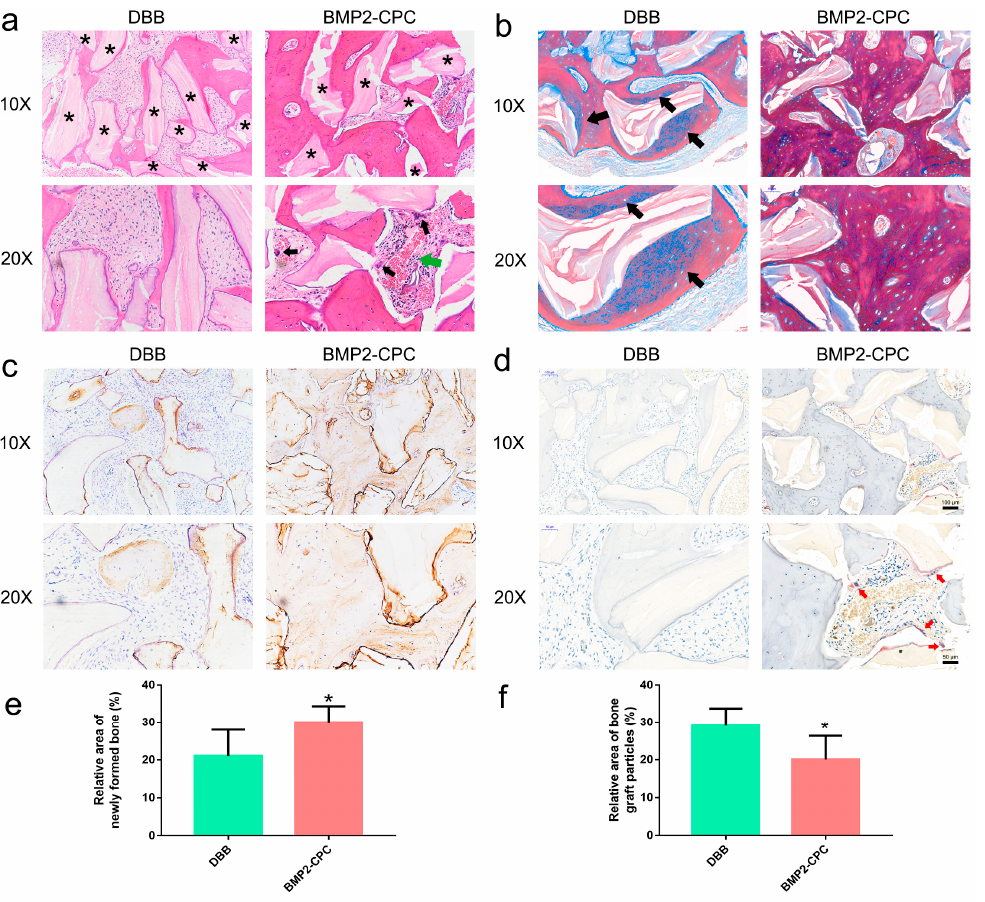
Figure 2. Clinical histological examination results. ( a ) HE staining results (* denotes residual bone graft particles, black arrows mark multinucleated osteoclast cells, green arrow marks vascularized bone marrow-like tissues); ( b ) Masson staining results (black arrows mark the stained immature bone); ( c ) immunohistochemical staining results for OCN; ( d ) TRAP staining results (red arrows mark the stained multinucleated osteoclasts); ( e ) quantification of the area of newly formed bone in each group; ( f ) quantification of the area of residual bone graft particles in each